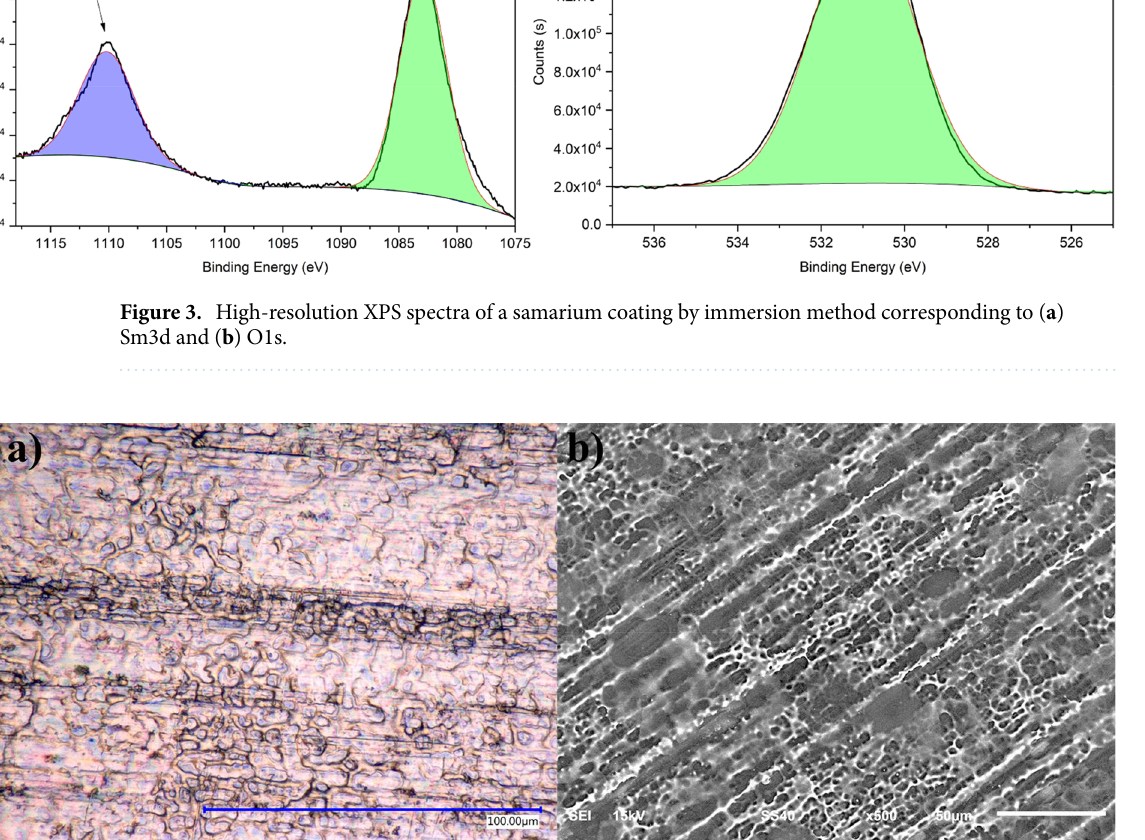
Figure 4. Aluminum surface with an Sm 2 (SO 4 ) 3 coating by APPJ observed using ( a ) optical (100 µm scale bar) and ( b ) electronic (10 µm scale bar)